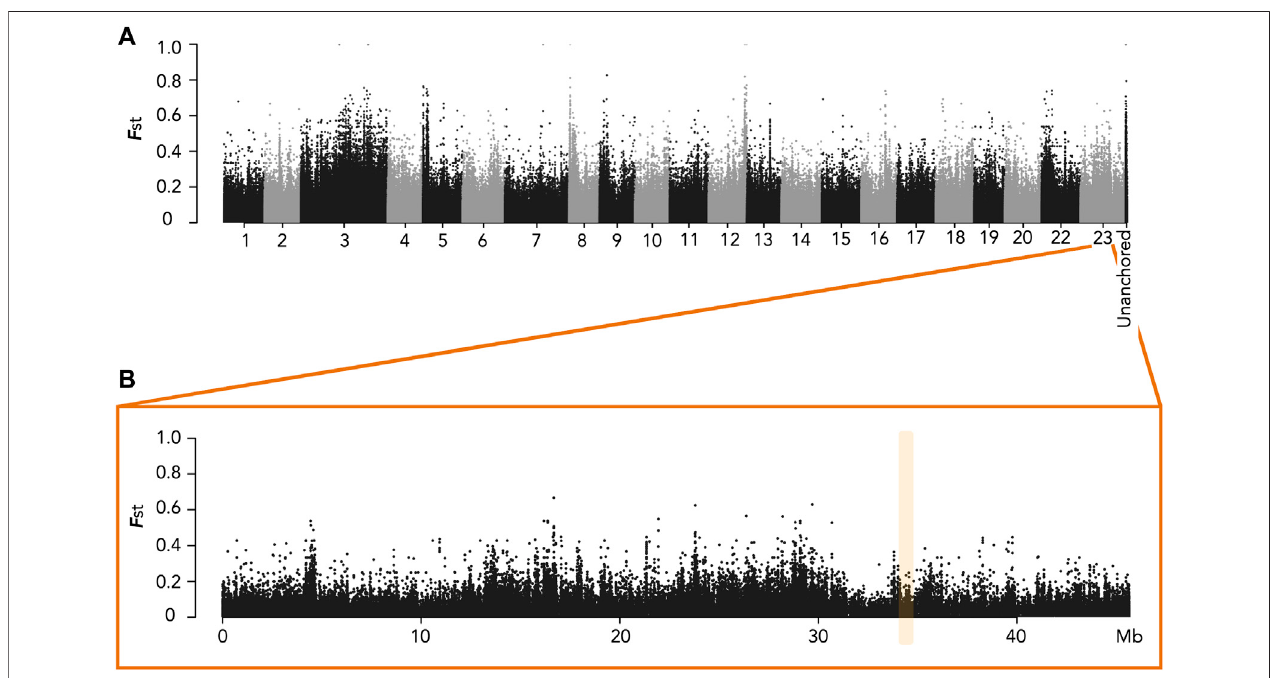
FIGURE 2 | Manhattan plots of Fst for sites fi xed or nearly fi xed for one sex and at intermediate frequencies for the other sex in the Hora population. (A) Plot for all Linkage Groups. Unanchored contigs were grouped into a single label. (B) Plot of LG23 with the amh region highlighted in yellow. No high F st was evidenced in the expected amh